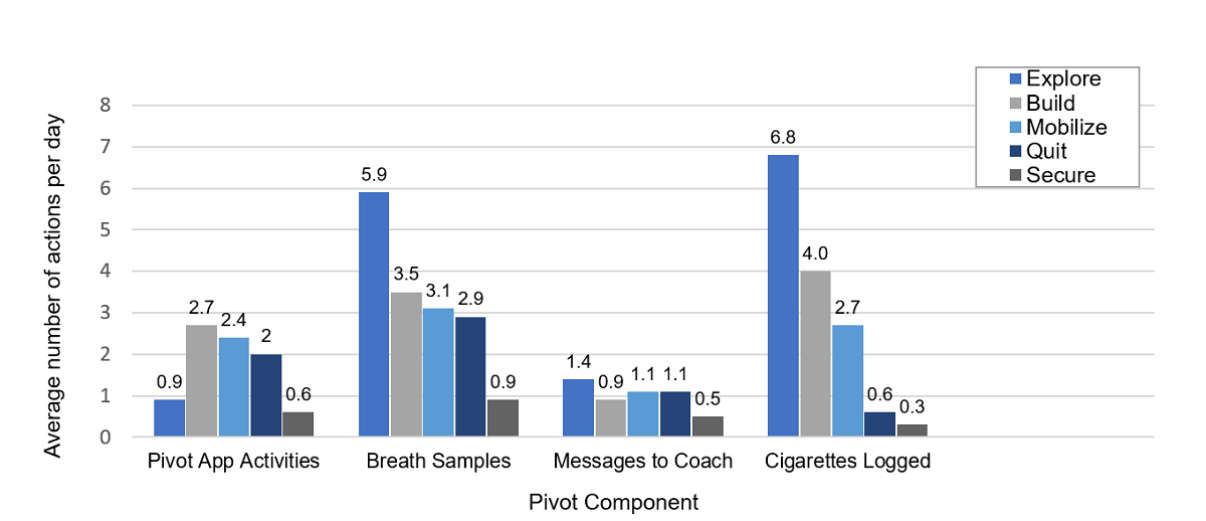
Figure 5. Participant engagement with the different components of Pivot; average actions per day, by stage, for all participants who entered stage.